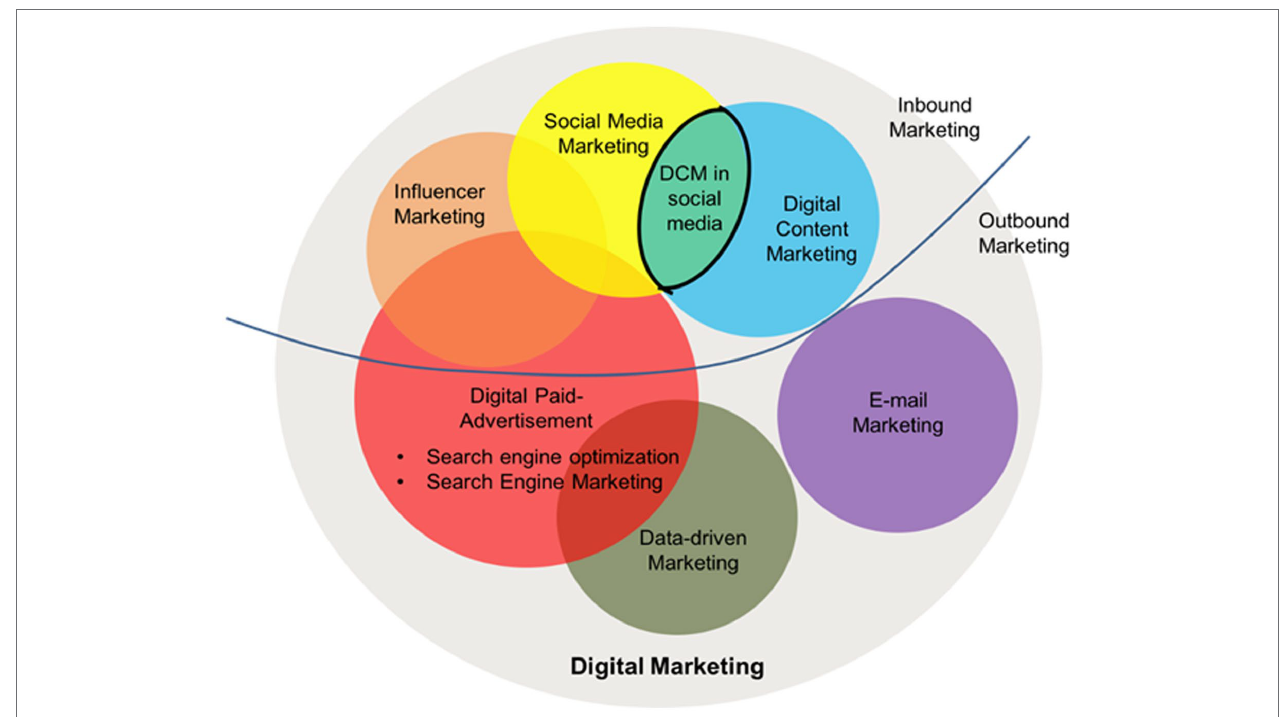
FIGURE 1 | A conceptual framework of digital